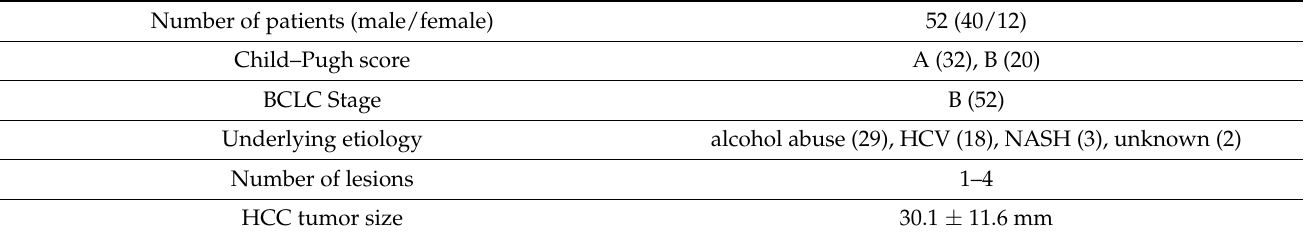
Table 1. Patient